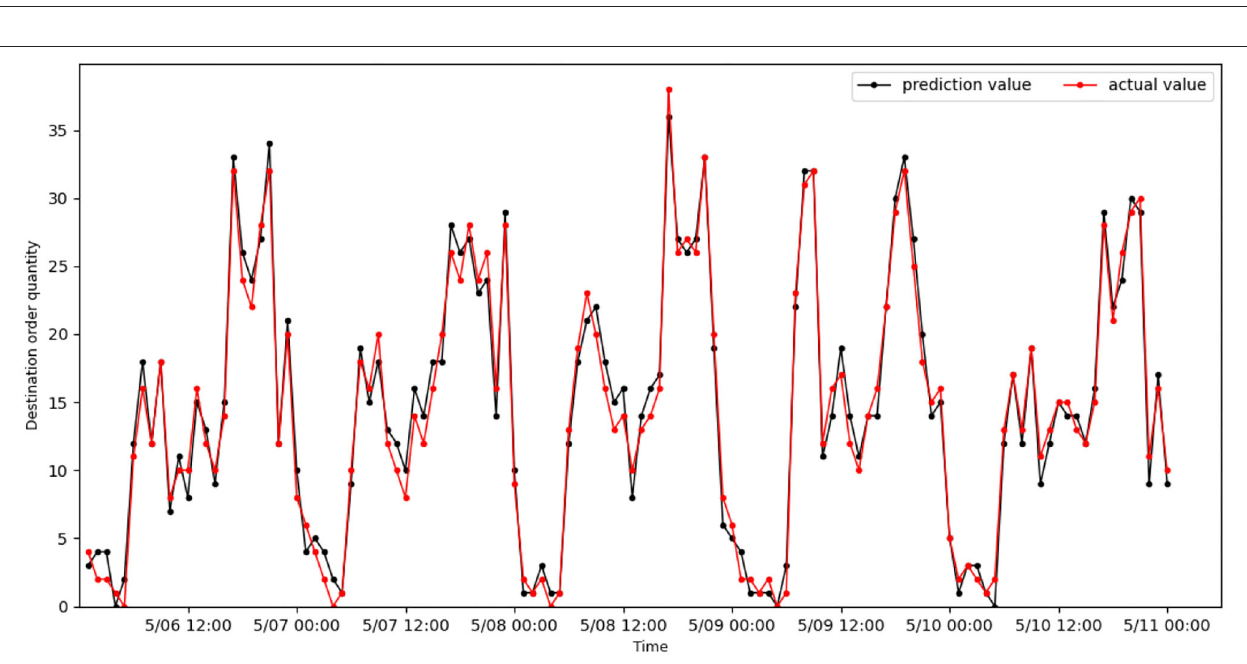
FIGURE 6 | Real online car-hailing destination orders in grid 96 are compared with predicted results.